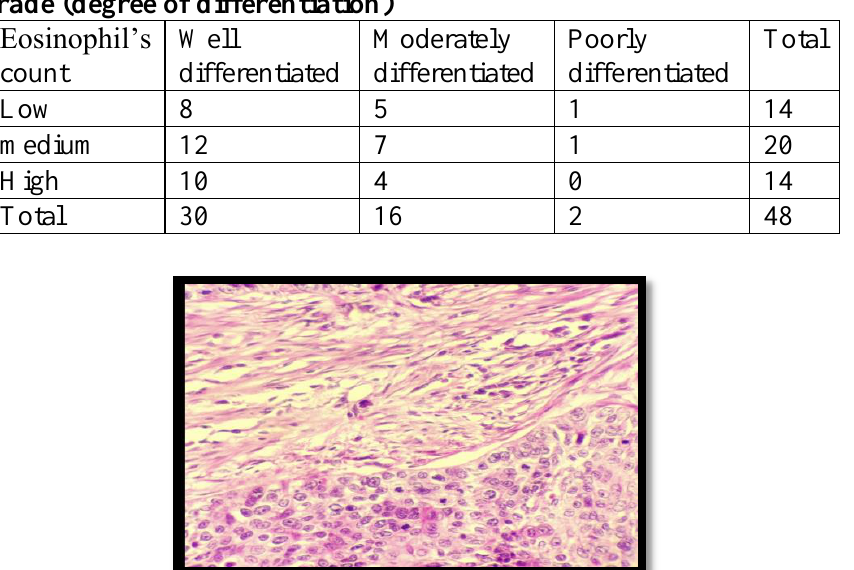
Figure 1 (x100): Histological feature of well differentiated squamous cell carcinoma with